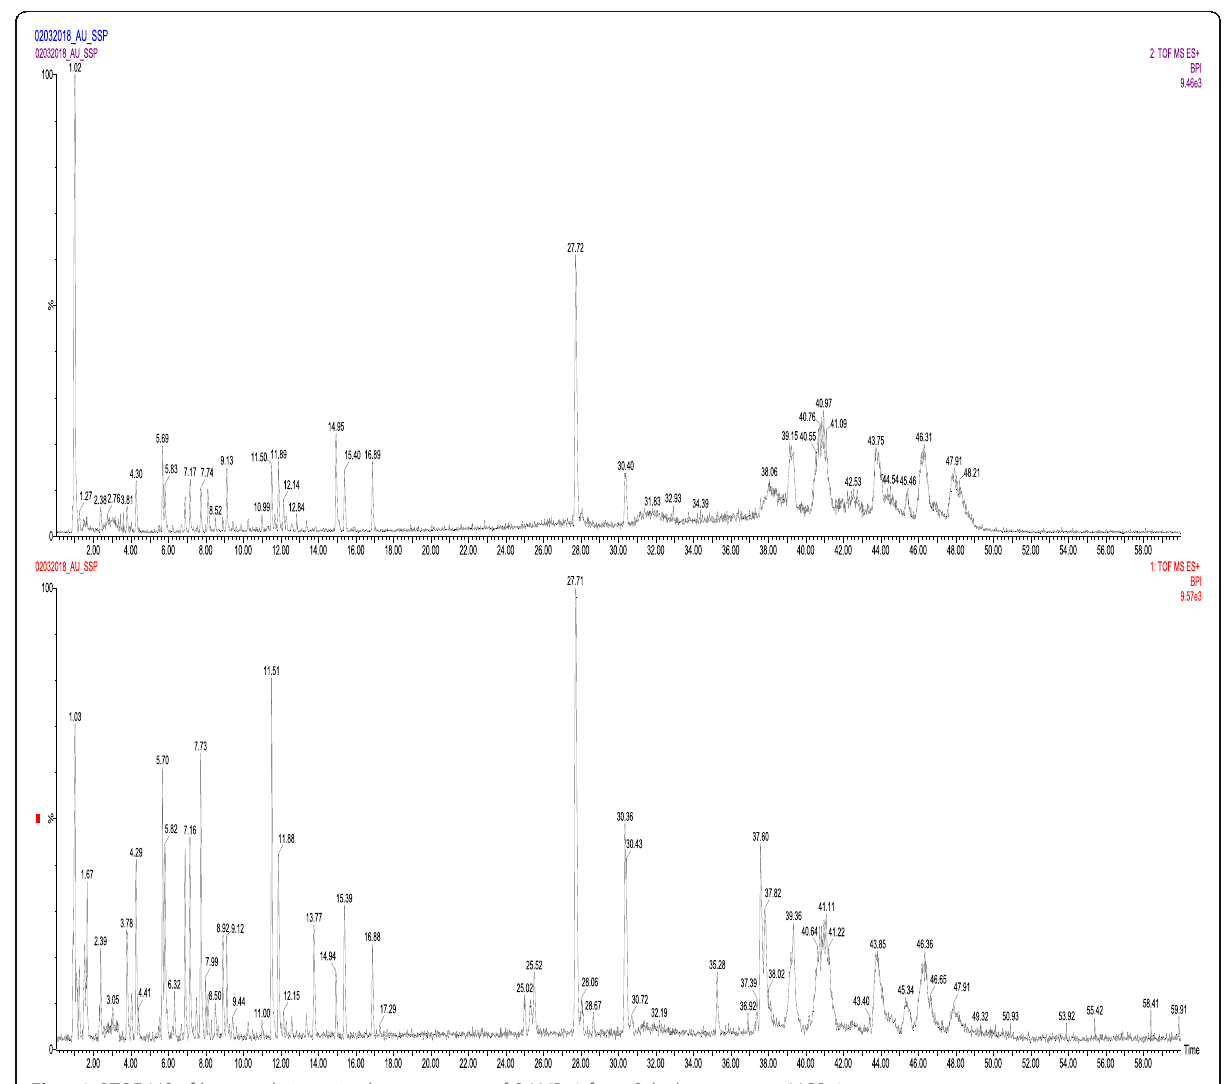
Fig. 10 QTOF-MS of base peak intensity chromatograms of S.AMP13 from S. hydrogenans var.